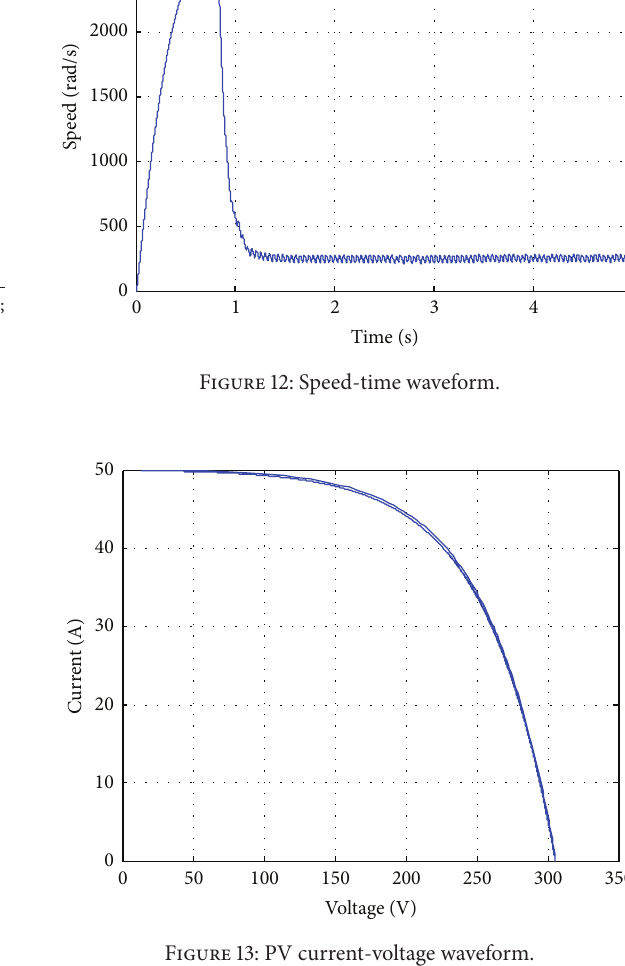
Figure 13: PV current-voltage waveform.